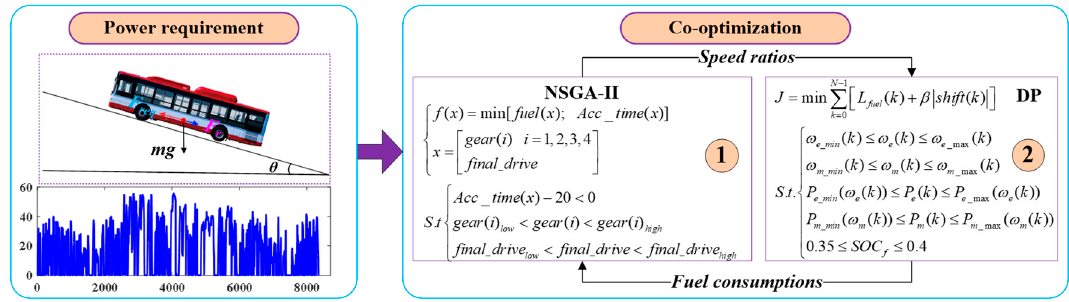
Figure 9. The framework of the co-optimization design.